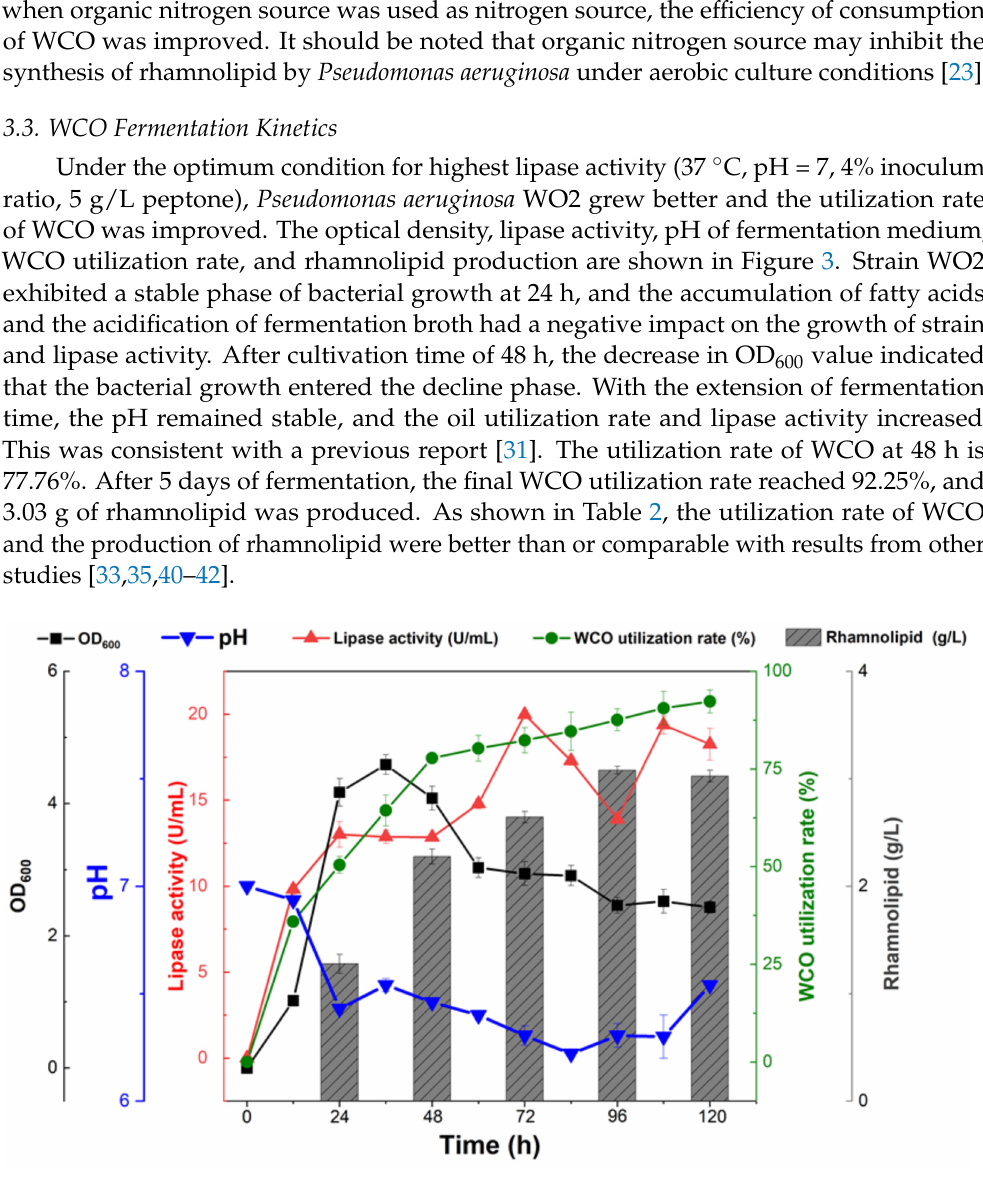
Figure 3. Process of WCO utilization under optimized